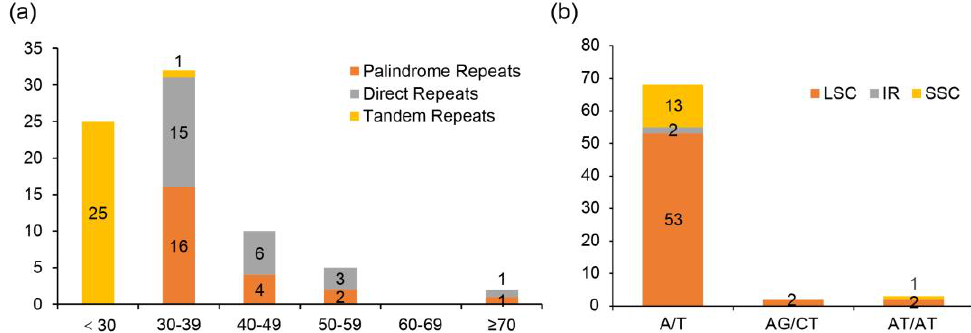
Figure 2. Repeats analysis of the plastome of Cinnamomum guizhouense C.Y. Deng et al. ( a ) Number and length of repeats; ( b ) Number and distribution of SSRs.